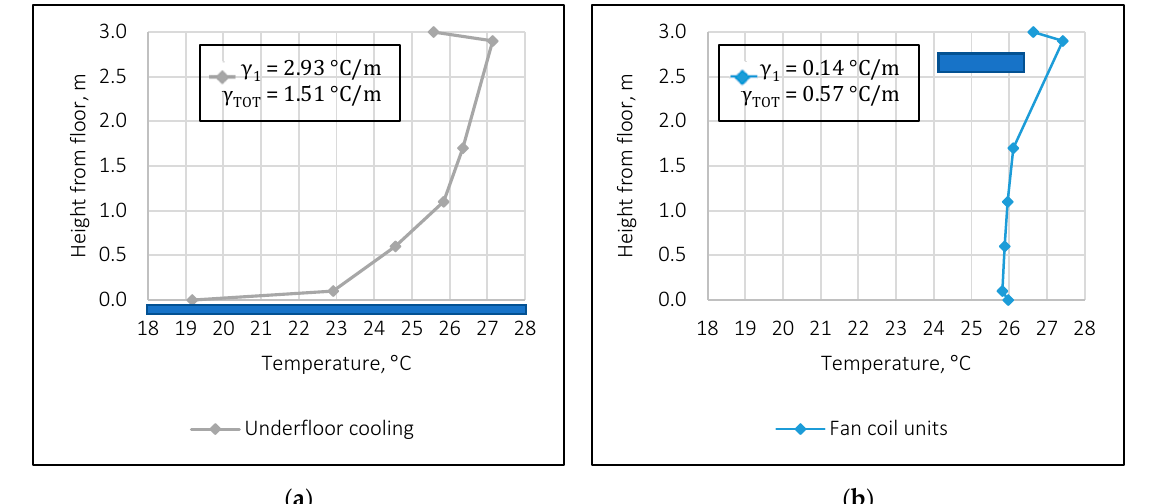
0.00.51.01.52.02.53.0